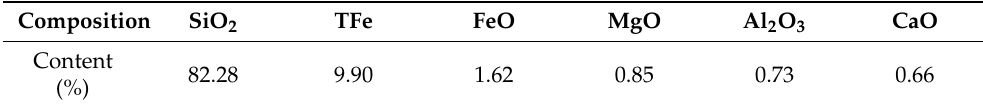
Table 1. Composition and content of iron tailings dust.